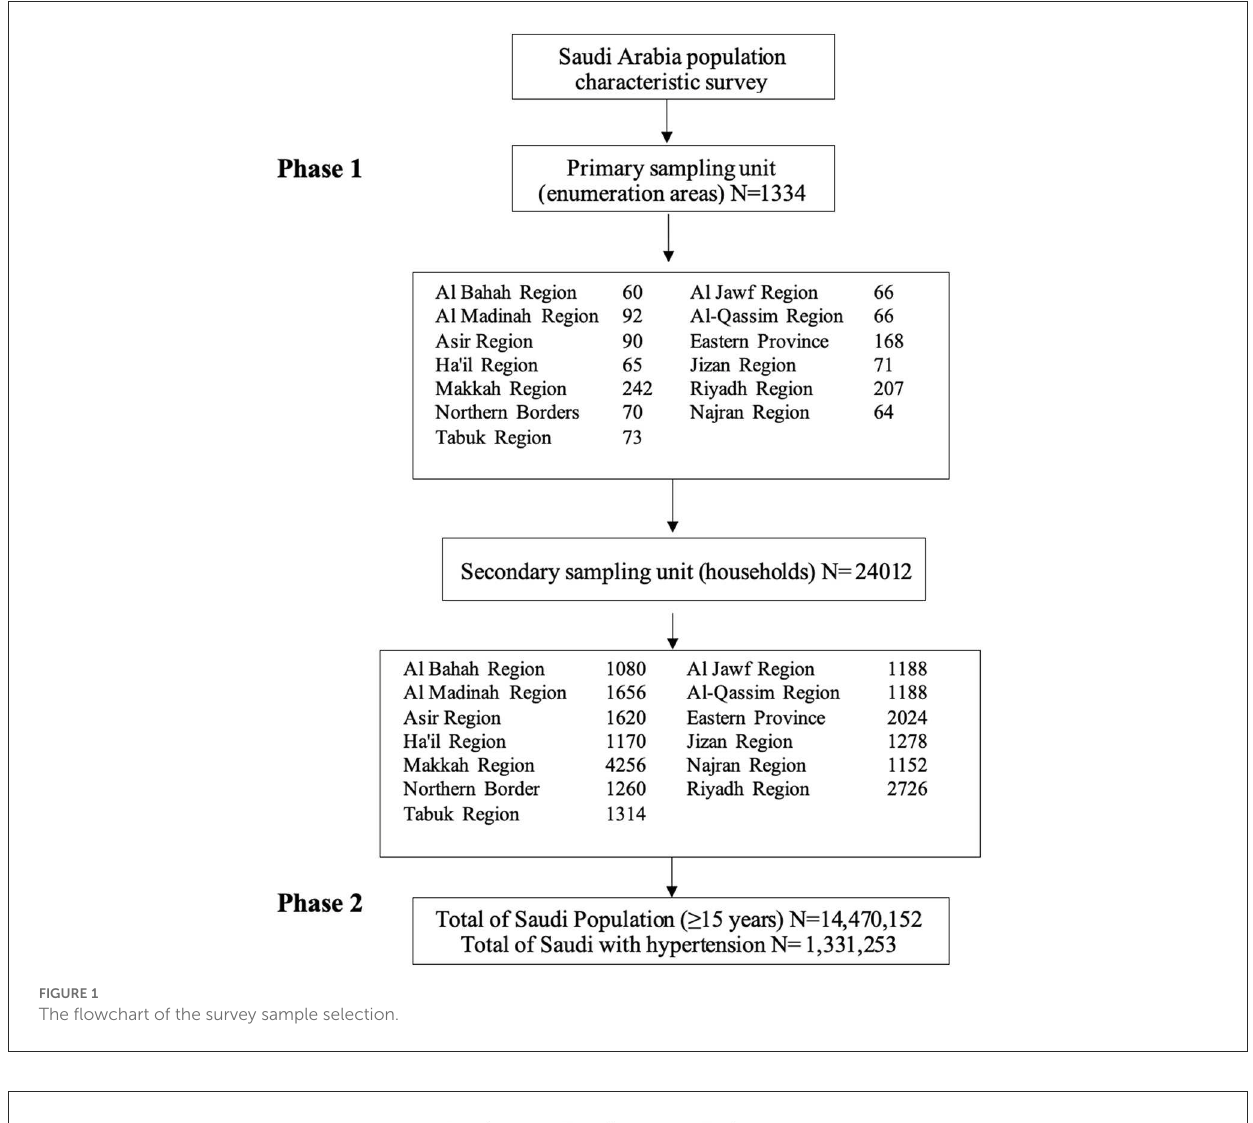
FIGURE1 The flowchart of the survey sample selection.